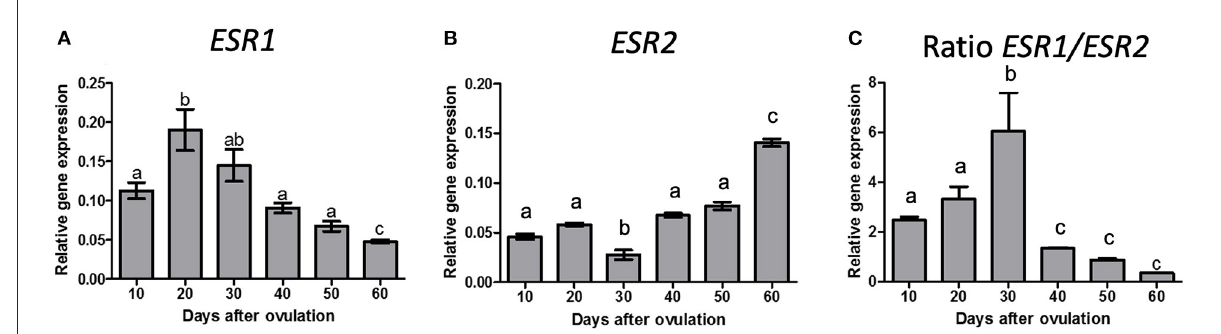
FIGURE1 Gene expression of ESR1 (A) , ESR2 (B) and ratio of ESR1/ESR2 (C) in canine CL during diestrus (10 to 60 days p.o.). Data are presented as mean ± standard error of relative gene expression ( n = 4 animals/group). Bars with different letters indicate significant differences among groups ( P <